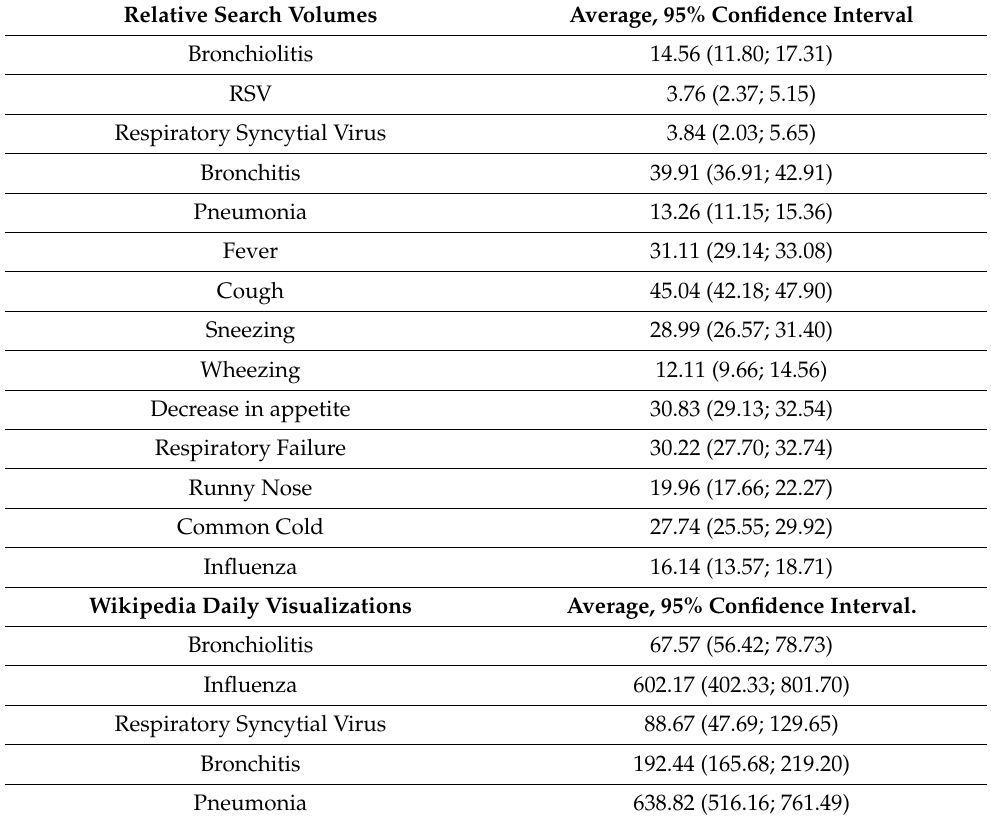
Table 3. Relative Search volumes of selected terms (overall estimate